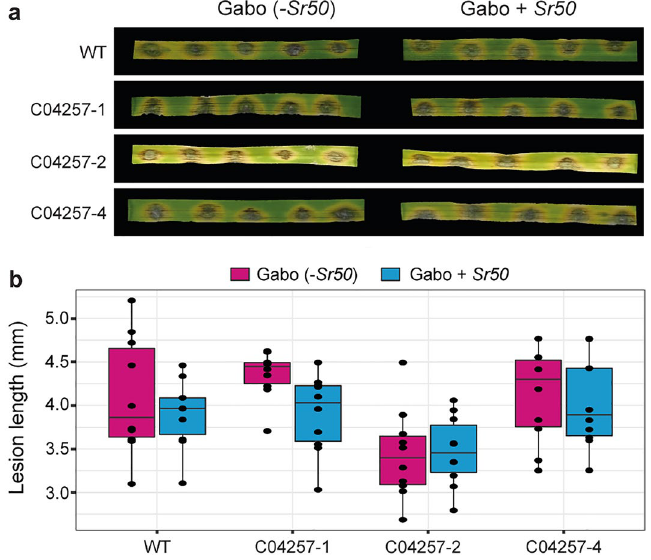
Figure 4. Integration of AvrSr50 into the MoT MGG_04257 locus did not lead to a Sr50 -dependant HR phenotype. ( a – b ) Introduction of PWT3p::PWT3SP::AvrSr50 into the MoT MGG_04257 locus did not lead to a visible Sr50 -mediated hypersensitive response (HR), for the three MoT transformants analysed (C04257- 1, C04257-2, C04257-4). The second leaf of two-week old wheat seedings of the lines Gabo ( Sr50- ) and Gabo + Sr50 were inoculated with conidial suspensions from each of the three separate transformants and wild-type (WT) MoT strain (N06047) using the spot inoculation method. Images were taken and lesion lengths measured at 4 days post-inoculation, with three biological replicates conducted (separate leaves). No statistical difference was evident (2-tailed t